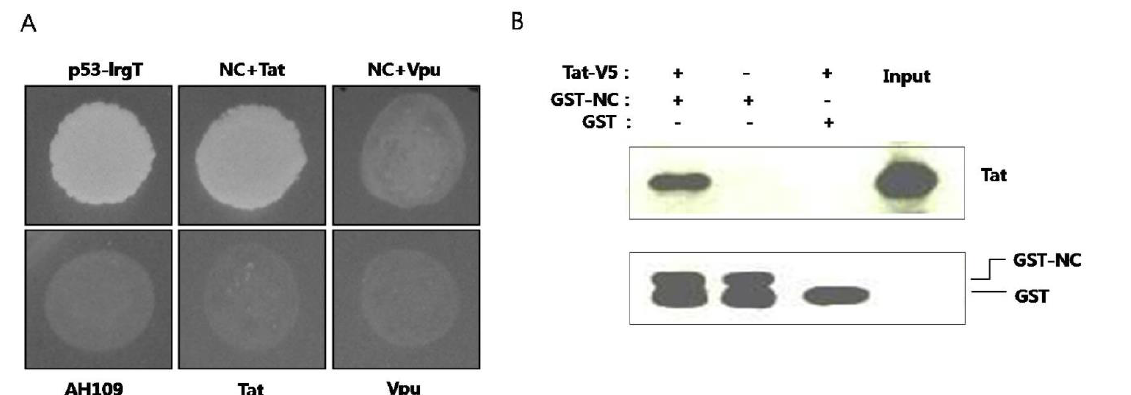
Figure 1. Interaction between HIV nucleocapsid (NC) protein and Tat ( A ) Plasmid expressing NC and plasmid expressing Tat were transformed to AH109 and the yeast was grown on media lacking histidine. Murine p53 and SV40 large T antigens were used as a positive control. HIV Vpu was used as a negative control. The lower panel shows yeast colonies resulting from interaction of the two proteins. Plasmids pGBK-NC, pGAD-Tat and pGAD-Vpu were constructed and utilized. pGBKT7-53 (murine p53) and pGADT7-T (SV40 large T antigen) were used as positive controls. Yeast strain AH109, transformed only with pGAD-Tat or pGAD-Vpu were used as negative controls; ( B ) Purified recombinant GST-fused NC was used to pulldown BKH21 cell lysate expressing Tat. GST was used as the negative control (third lane). pcDNA/V5-Tat was transfected to BHK-21 cells. After 24 h, a RIPA lysis buffer was added and lysis was performed at 4 °C for 30 min. The pellet was discarded after centrifugation and the lysate was obtained. GST or GST-NC and 30 μL of glutathione sepharose 4B bead was added to the lysate and the mixture was incubated at 4 °C overnight. HNGT buffer was used for washing and bound proteins were eluted after boiling with a 4XSDS sample buffer; ( C ) Flag-tagged NC and V5-tagged Tat or V5-tagged Vpu were expressed in HEK293 cells. The lysate was subjected to an immunoprecipitation with the anti-Flag antibody and detected with the anti-V5 antibody in a western blot analysis. The anti-IgG antibody was used a as the negative control; ( D ) Flag-tagged NC (green) and V5-tagged Tat (red) were expressed in HEK293 cells and observed under a confocal laser scanning microscope. At least three experiments were performed with essentially the same